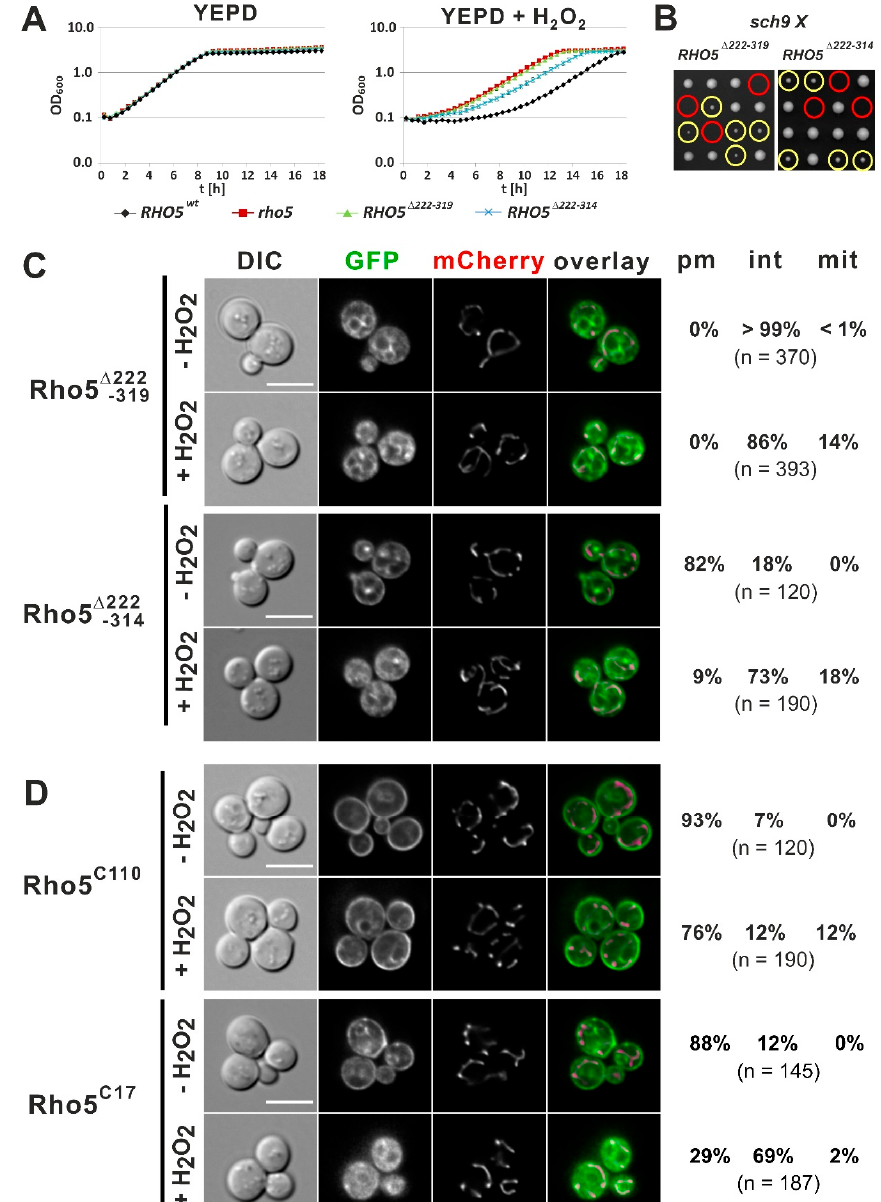
Figure 4. Growth and response to oxidative stress of a rho5 mutant lacking the yeast-specific extension and analysis of its requirement for intracellular distribution. ( A ) Comparative growth behavior of strains carrying a wild-type RHO5 allele, a rho5 deletion, or the mutant allele lacking the extension ( RHO5 ∆ 222 – 319 ) and the same allele with five more amino acids of the extension ( RHO5 ∆ 222 – 314 ). ( B ) Tetrad analyses of crosses from strains carrying the indicated RHO5 allele to a sch9 deletion strain performed on YEPD. Parental strains employed were HD56-R2 ( RHO5 ∆ 222 – 319 ) and HOD388-2D ( RHO5 ∆ 222 – 314 ), each crossed with HOD348-4D ( sch9 ). Yellow and red circles indicate segregants with a RHO5 sch9 and a mutant RHO5 sch9 constitution, respectively. ( C , D ) Life-cell fluorescence microscopy of a rho5 deletion strain producing Idp1-mCherry as a mitochondrial marker (HCSO76-1A) and plasmid-encoded N-terminal GFP fusions of the Rho5 variants indicated. Plasmids introduced were pLAO5 (GFP-Rho5 ∆ 222–319 ), pJJH2616 (GFP-Rho5 ∆ 222–314 ), pJJH2562 (GFP-Rho5 C110 ), pCSO94 (GFP-Rho5 C17 ). Compare Table 2 for more information on plasmid features. Growth conditions, scales, and determination of distribution numbers were as described in the legend of Figure